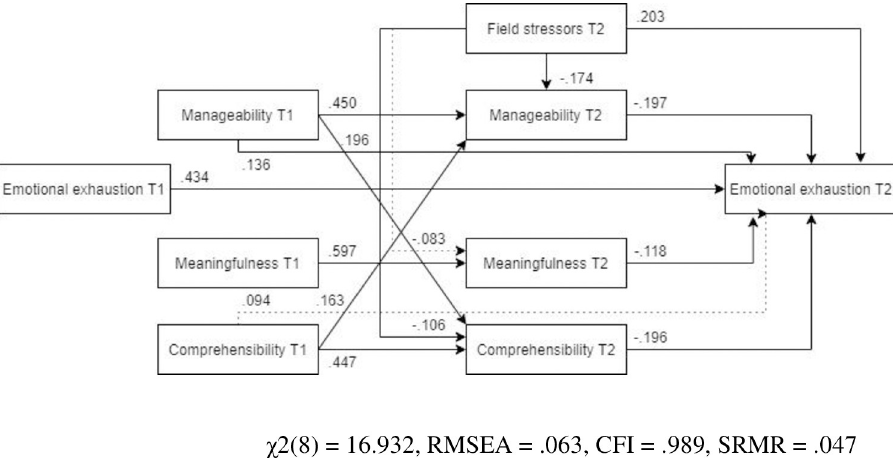
Fig 13. Tested structural equation model for emotional exhaustion—females. χ 2(8) = 16.932, RMSEA = .063, CFI = .989, SRMR = .047.